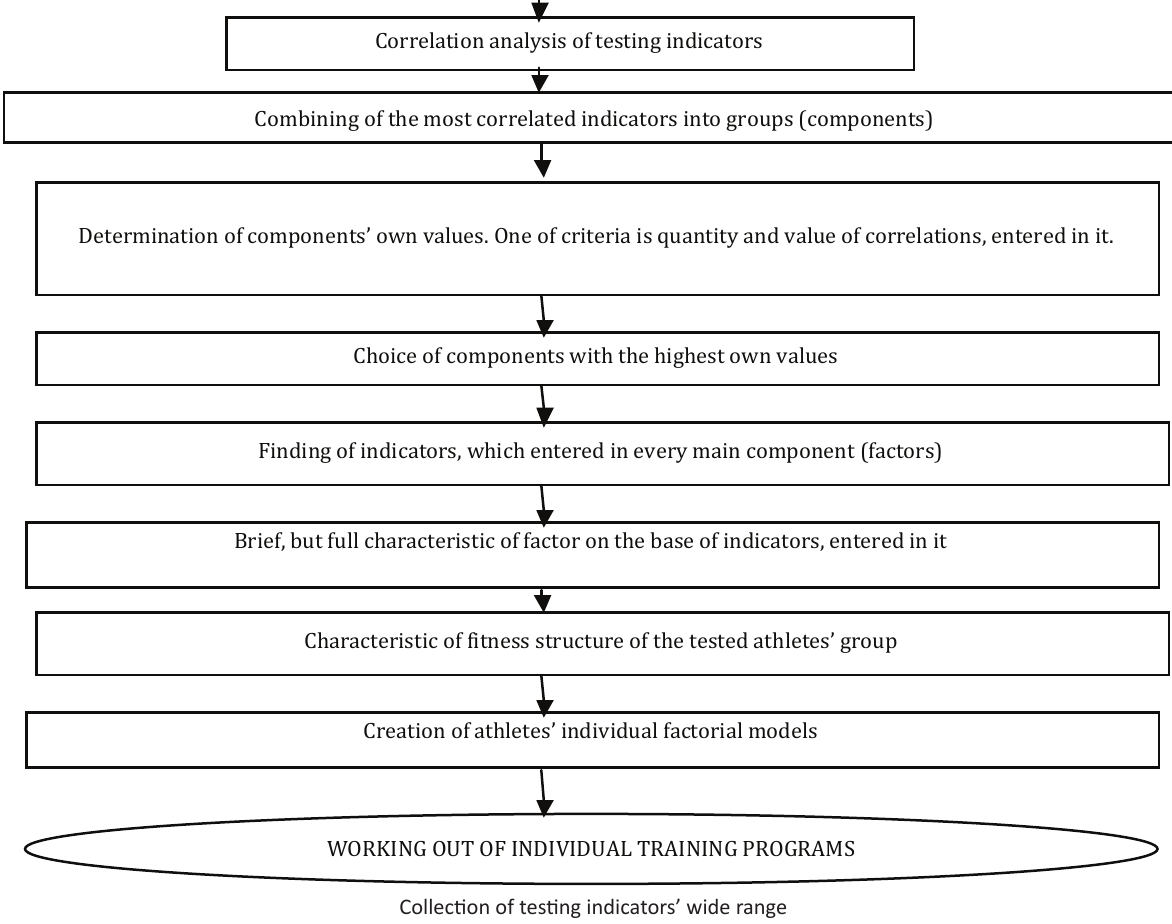
Fig. 3. Scheme of trainings’ individual programs’ development with the help of factorial analysis by method of main